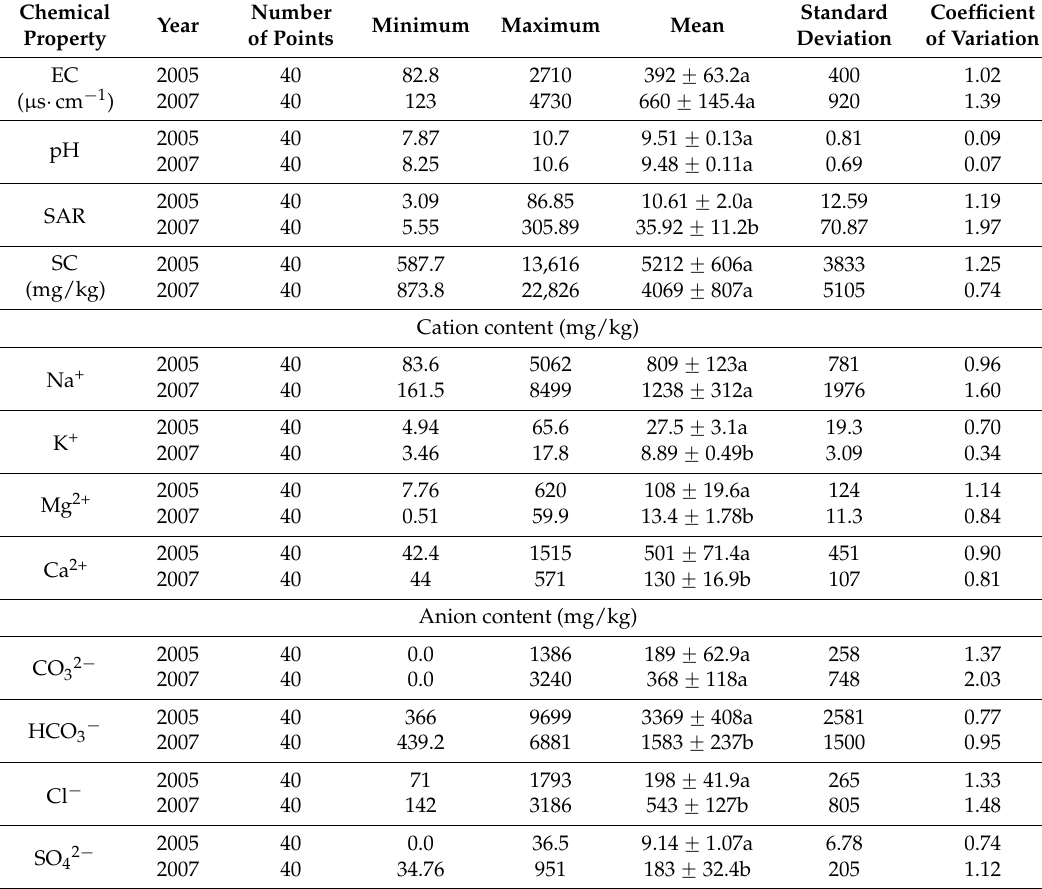
Table 1. Descriptive statistics on soil ions and salinity parameters in 2005 and